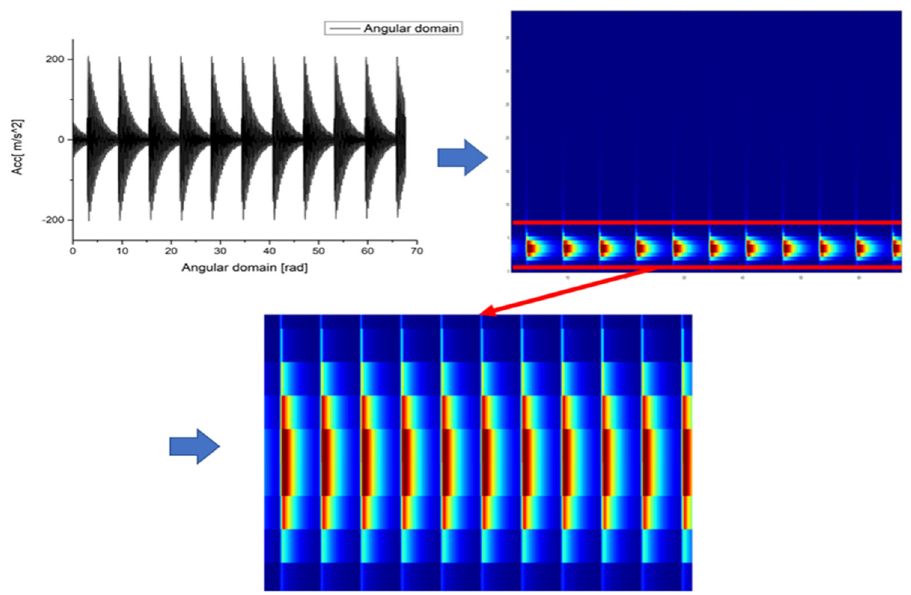
Figure 14. Frequency band due to wheel flats.